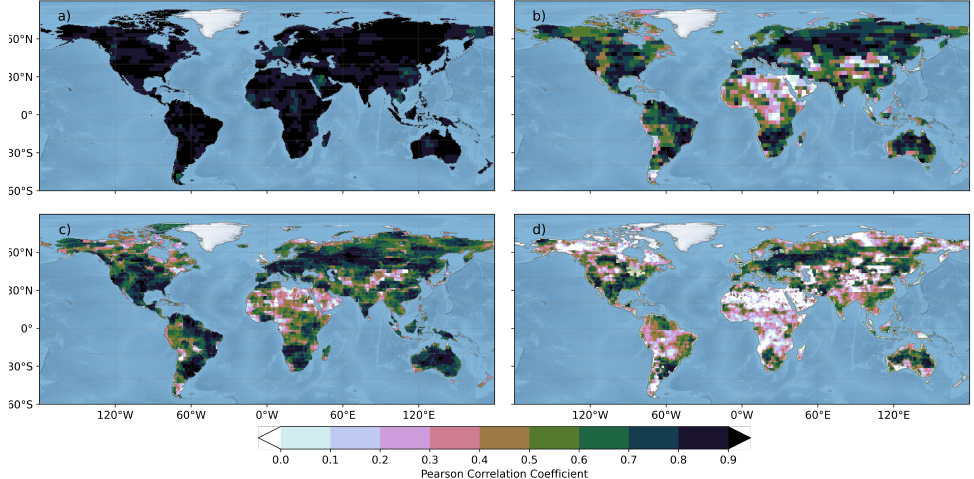
Figure 4. Correlations with GRACE for TWS_CSEOF ( a ), HG2019 ( b ), Li2021 ( c ), and GLDAS2 ( d